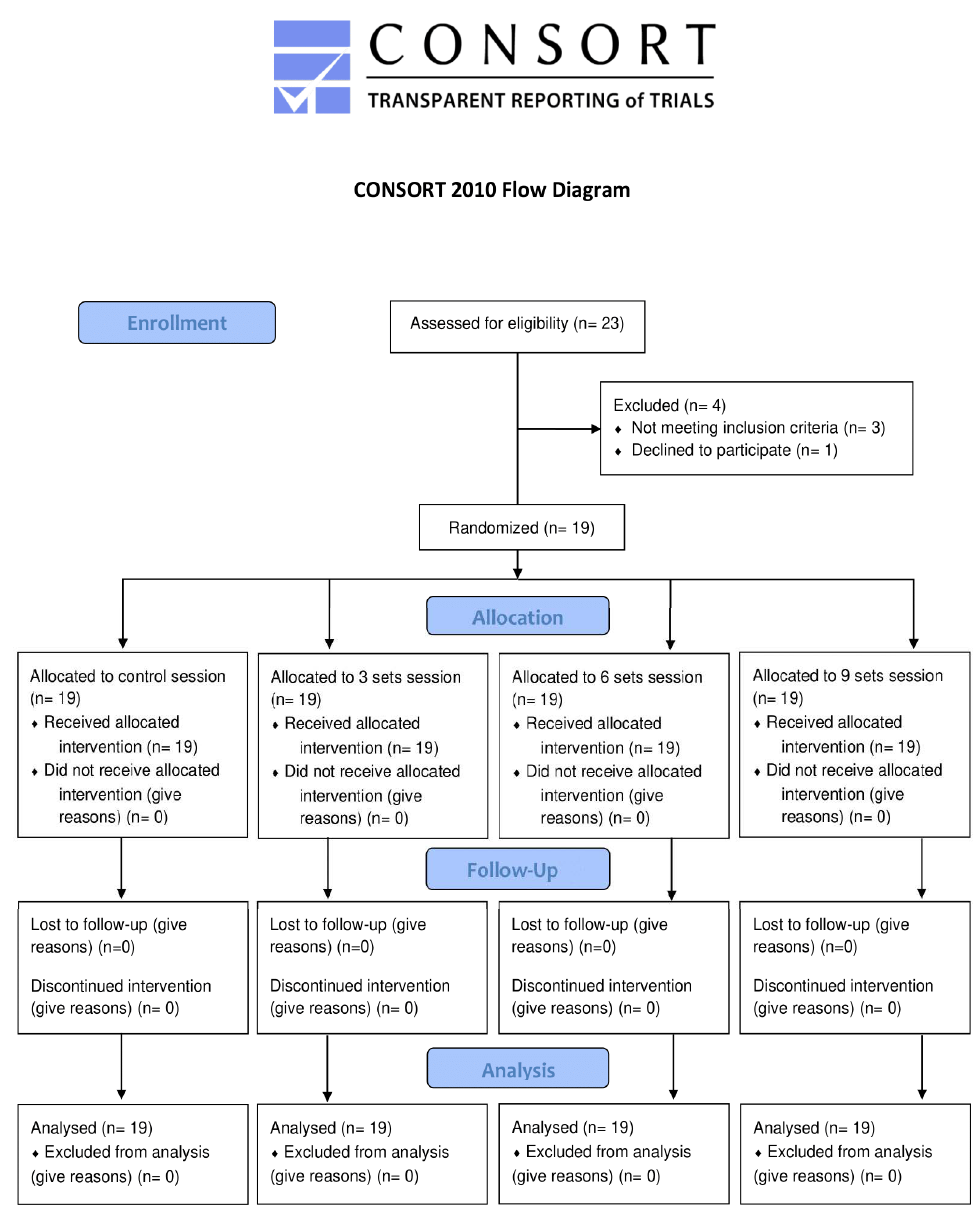
Figure 1. Flow diagram of the study. Table 1. Anthropometric and metabolic characteristics of the sample.